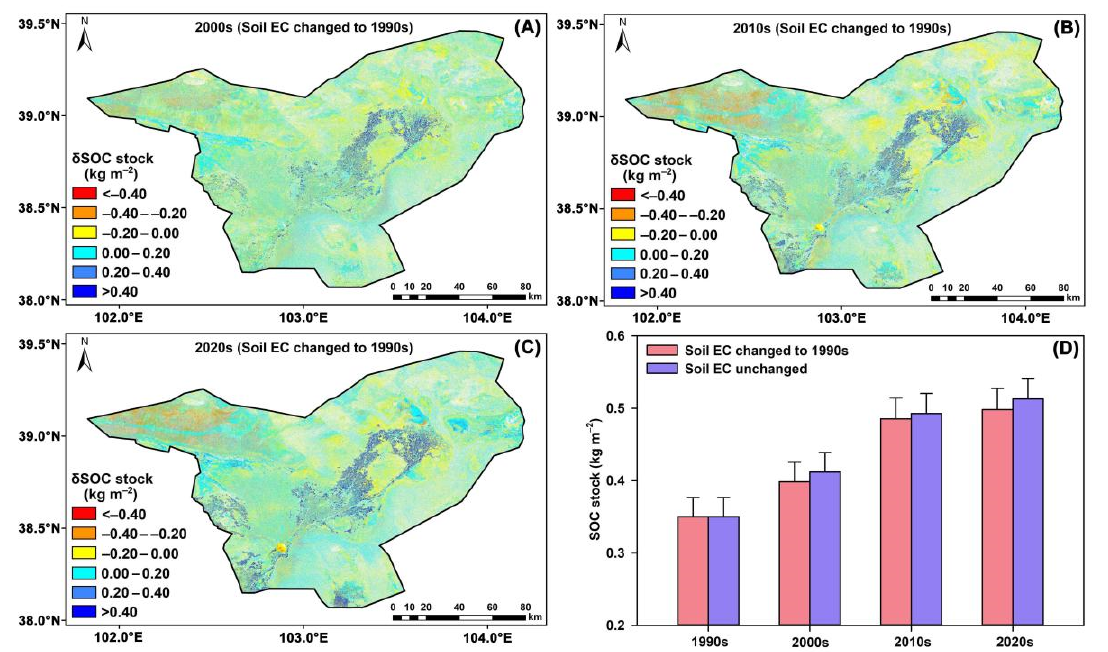
Figure 12. Effects of soil salinization on SOC stock over the past three decades. Note: ( A ), ( B ), and ( C ) indicate δ SOC stock (differences between actual estimates and predictions under salt-stable scenarios) for the 2000s, 2010s, and 2020s, respectively, and ( D ) is the area-weighted averages and standard deviations of SOC stock for different periods. Here, we assumed a salt-stable scenario (i.e., soil salinity has been stable over time since 1990) and examined SOC stock differences between actual estimates and projections under the salt-stable scenario for each period. Table 3. Summary of the area-weighted averages and standard deviations of SOC stock differences ( δ SOC stock) by land use and land cover type under different salinity change scenarios.